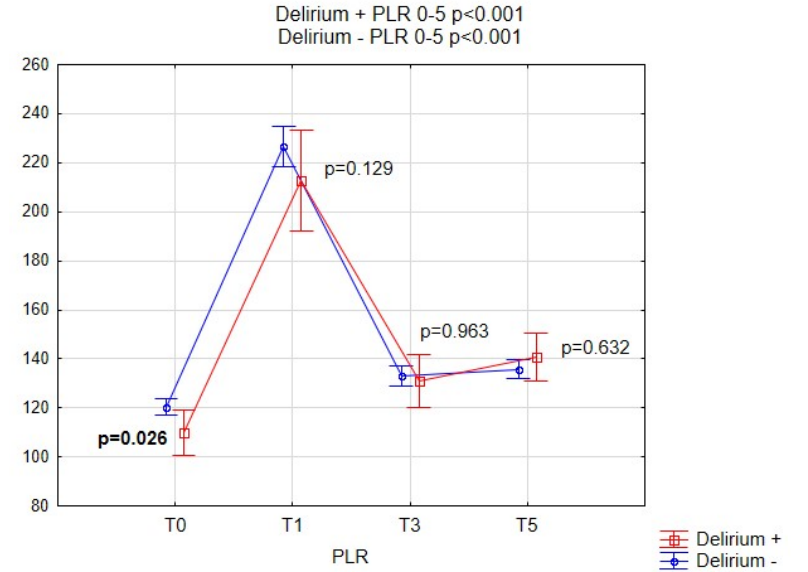
Figure 3. Pre-operative and post-operative PLR values for patients with and without POD. PLR, platelet-to-lymphocyte ratio; POD, Postoperative delirium.